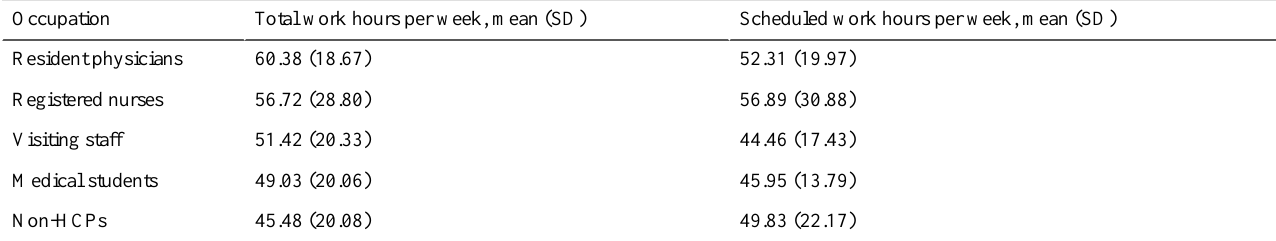
Table 1. Total work hours and scheduled work hours among 5